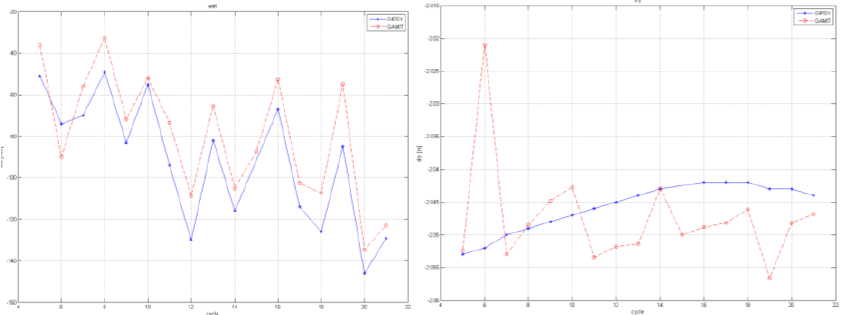
Figure 18. Differences of the wet (left) and dry (right) troposphere delays as derived by GAMIT and GIPSY at the time of the Jason-3, (No. 18) overpass the CDN1 Cal/Val site.